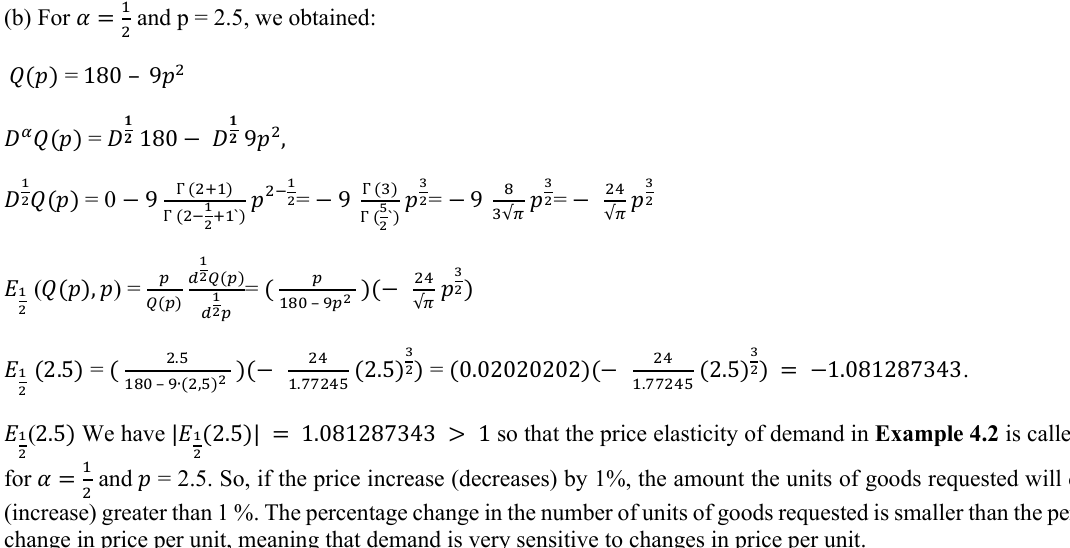
, for 1 ≤ 𝑝 ≤ 4, 𝑘 , (cid:2875)(cid:2873) , (cid:2873)(cid:2868) , (cid:2869)(cid:2868) , (cid:2869) (cid:2869)(cid:2868)(cid:2868) (cid:2869)(cid:2868)(cid:2868) (cid:2869)(cid:2868)(cid:2868) (cid:2869)(cid:2868)(cid:2868) (cid:2869)(cid:2868)(cid:2868)